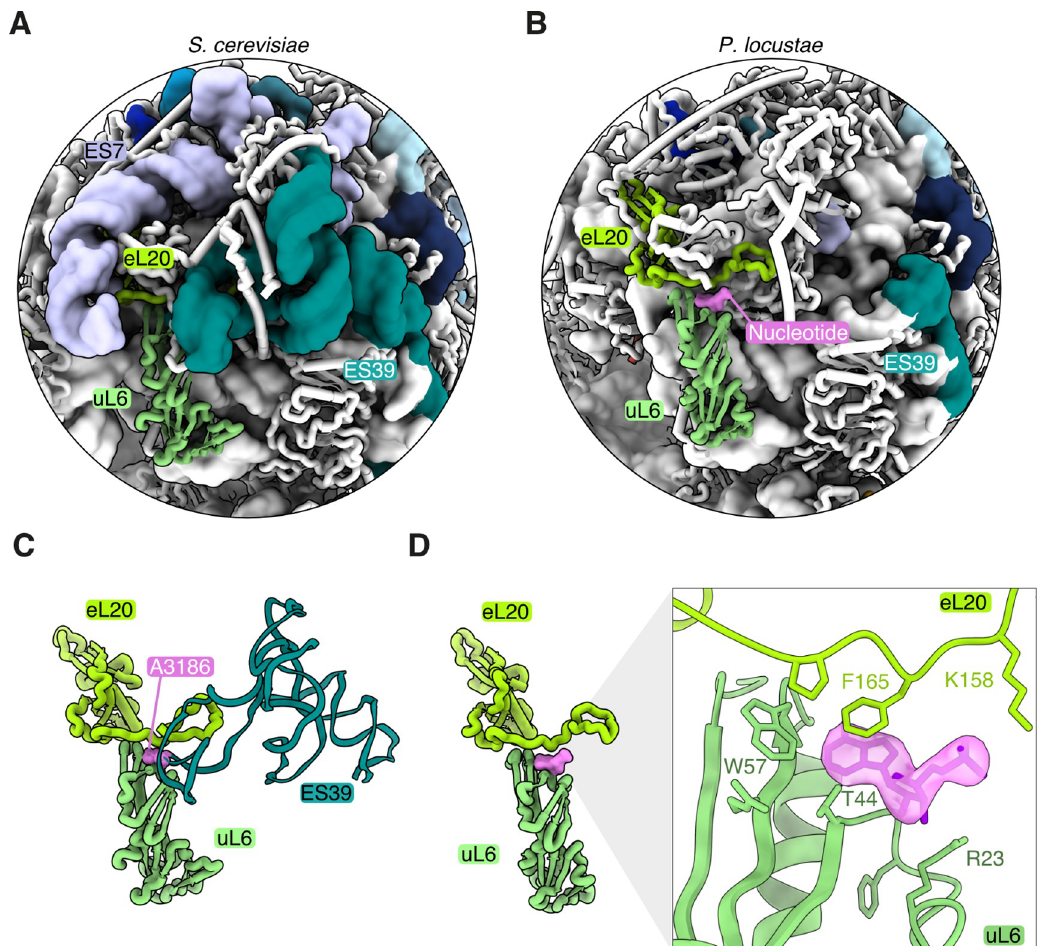
Fig 4. Reductive evolution of ES39 to a single structural nucleotide. A comparison of ES7 and ES39 between (A) S . cerevisiae (PDB 4V88) and (B) P . locustae (PDB 6ZU5). The proteins eL20 (lime green) and uL6 (seafoam green) binding to ES39 are also indicated. (C) An isolated, close-up view of the binding interface between eL20 and uL6, stabilized by A3186 (pink) from ES39 in the S . cerevisiae ribosome (PDB 4V88). (D) A single nucleotide (pink) is bound to the protein–protein interface in P . locustae . The inset depicts the cryo–electron microscopy map consistent with a single nucleotide between eL20 and uL6.